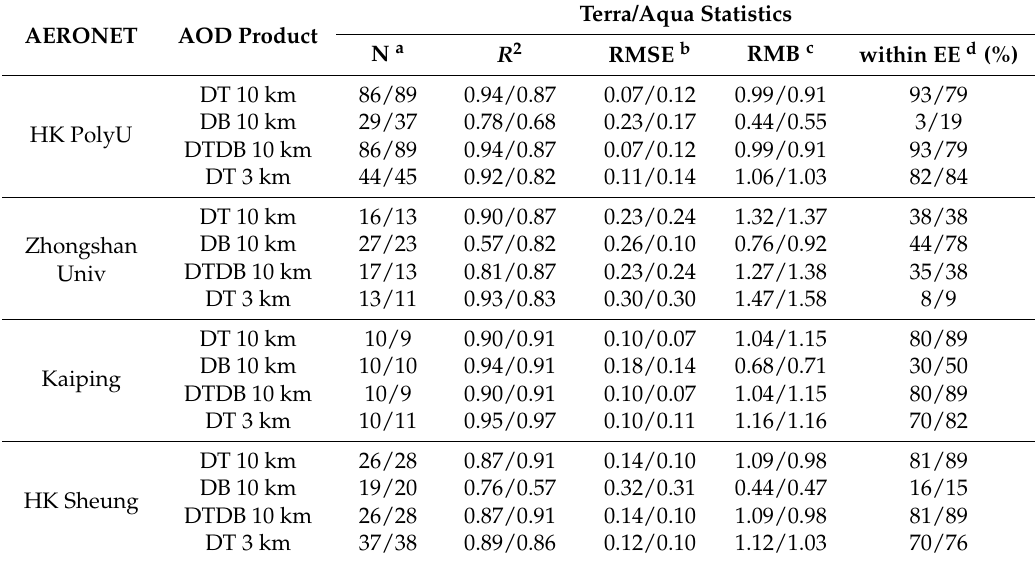
Table 2. Statistics of the site-level comparisons between different MODIS AOD products and AERONET